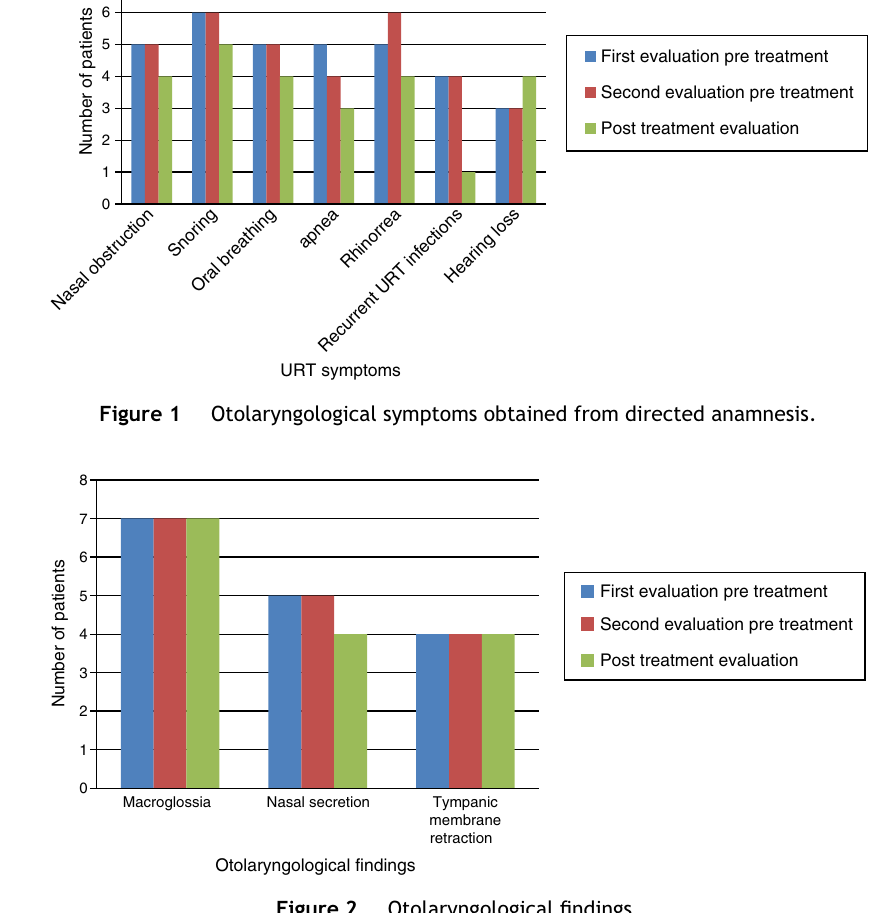
Figure 2 Otolaryngological findings.